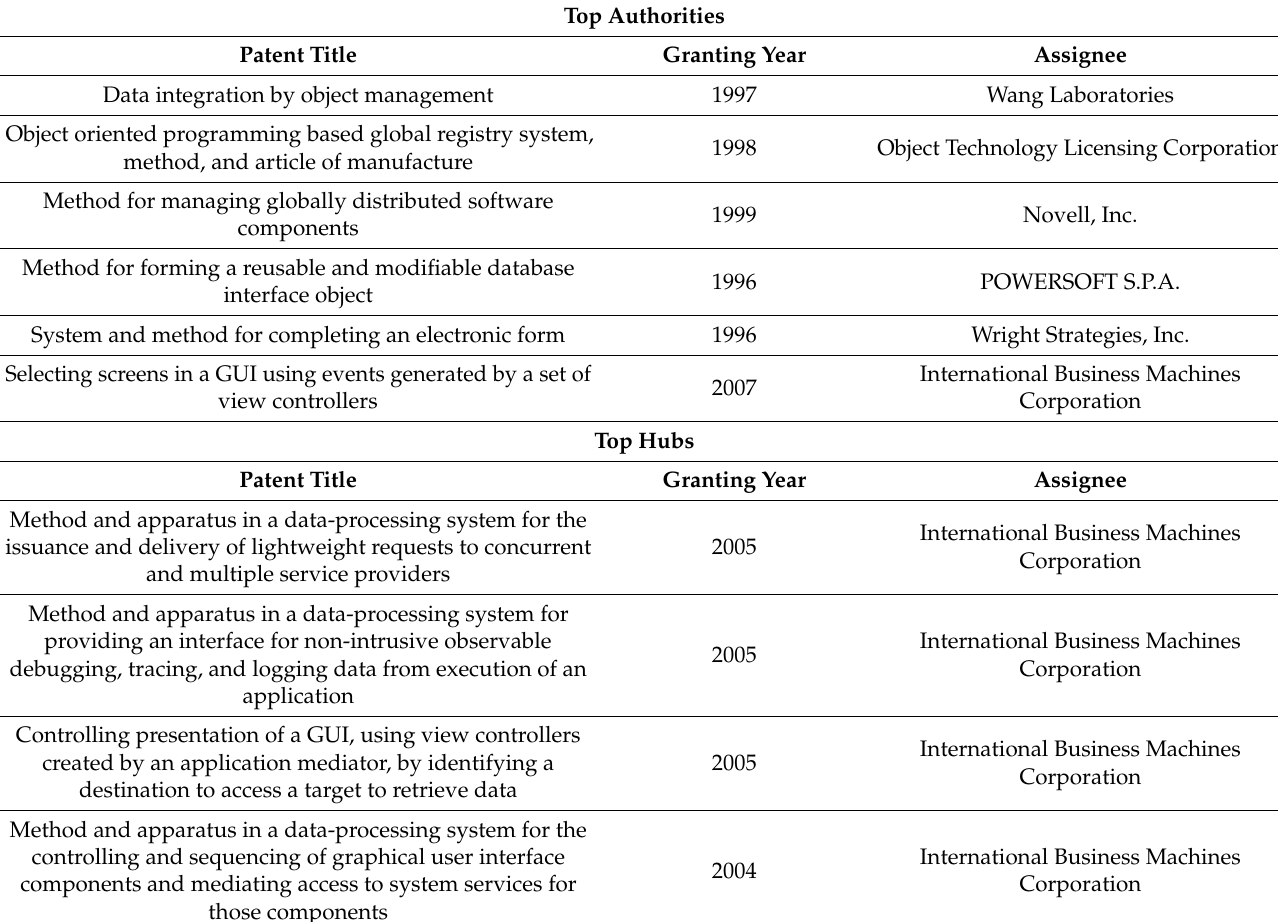
Table 8. Top authorities and hubs in